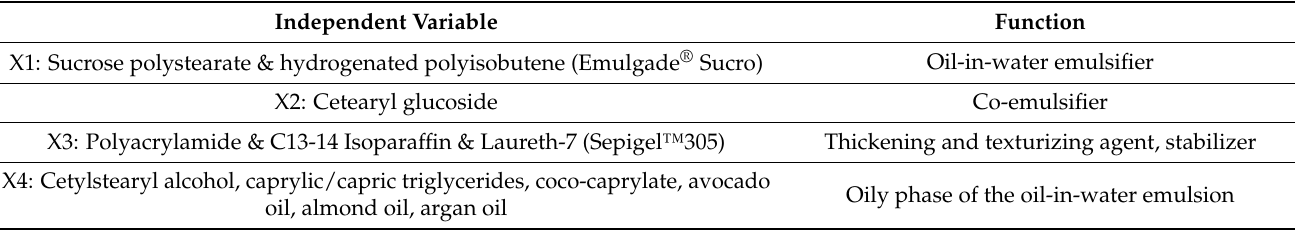
Table 10. Input variables of the experimental